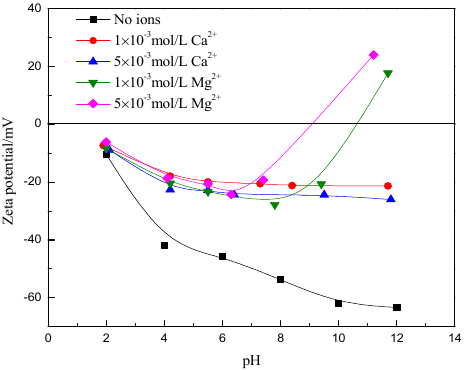
Figure 4. Zeta potentials of muscovite as a function of pH in deionized water with Ca 2+ and Mg 2+ .